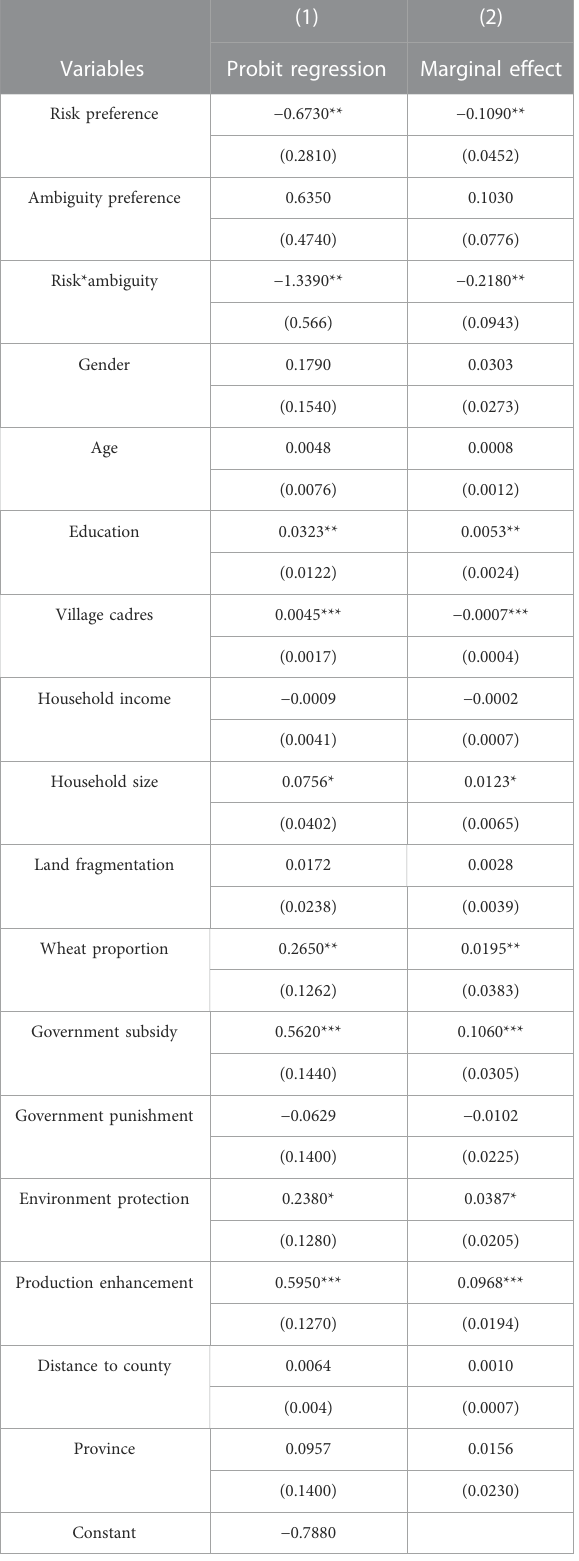
TABLE 8 Interaction of risk preference and ambiguity